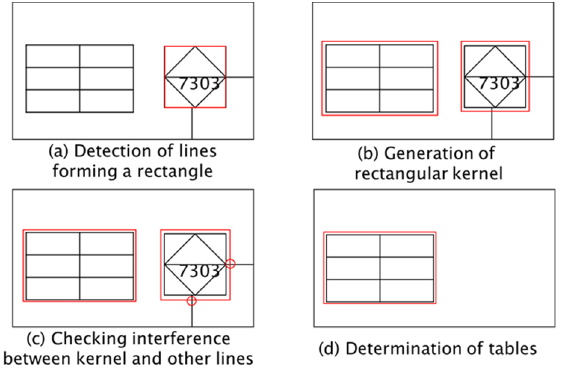
Figure 11. Table recognition in P&ID.